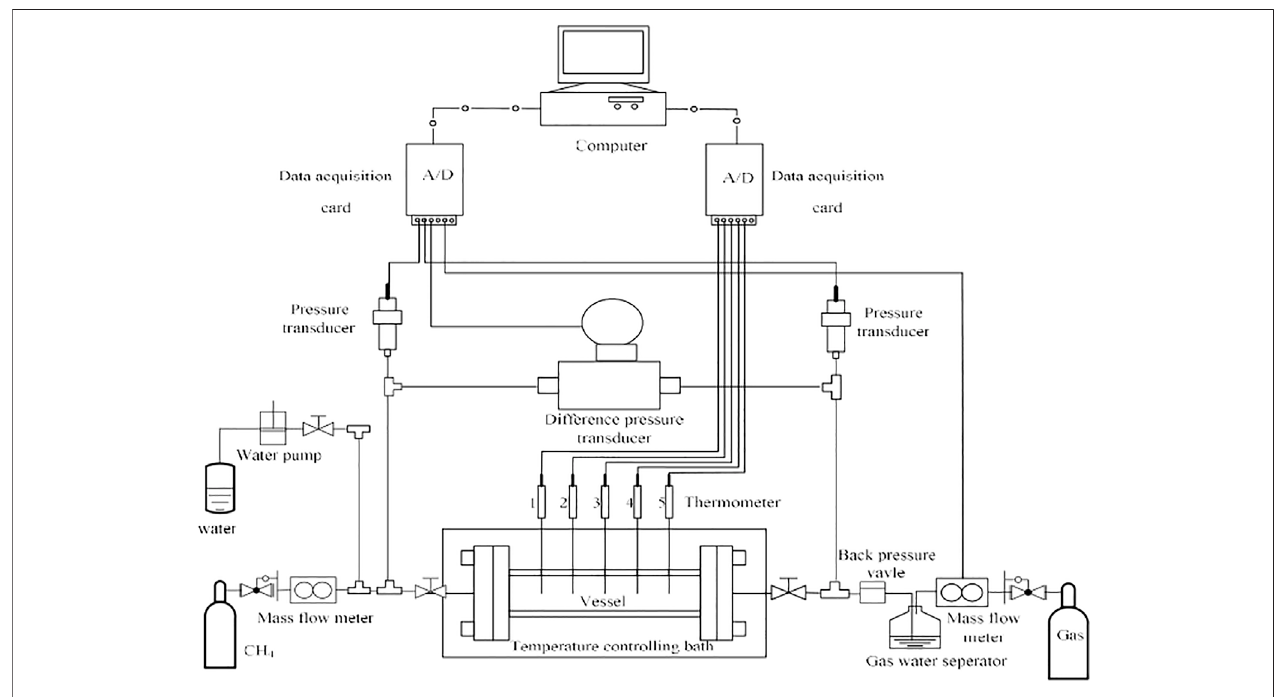
FIGURE 2 | Methane hydrate experimental apparatus